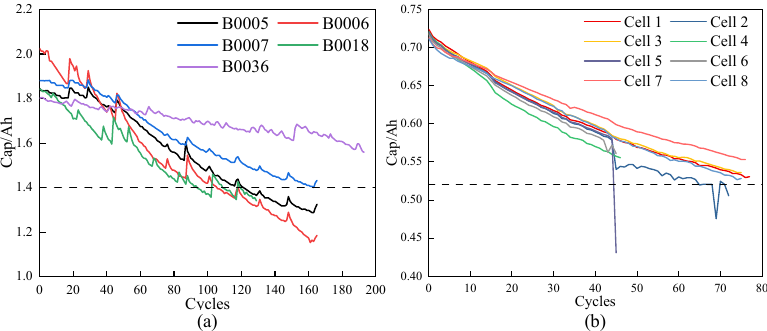
Figure 9. Battery capacity of different batteries varies with the number of cycles: ( a ) batteries in NASA dataset, ( b ) batteries in Oxford dataset.